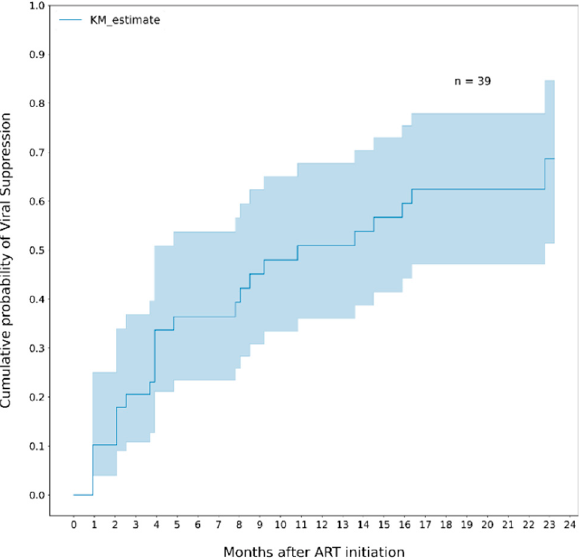
Figure 1. Cumulative probability of viral suppression (VL ≤ 400 copies/mL) among all infants. Note. The area in blue represents the 95% CI.